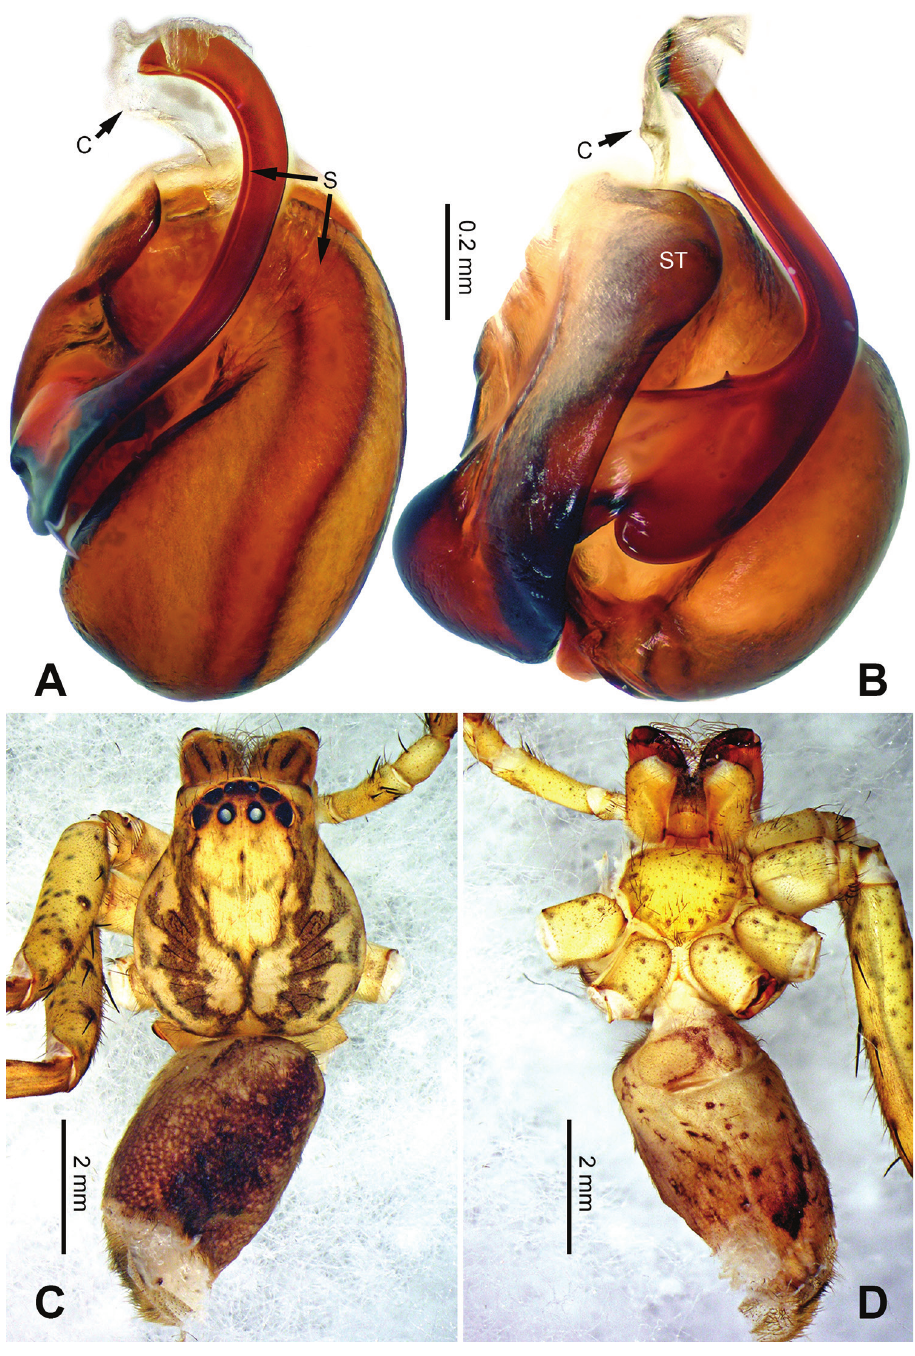
Figure 7. Pseudopoda conaensis Zhao & Li, sp. n., male holotype. A Bulb, ventral view B Bulb, dorsal view C Habitus, dorsal view D Habitus, ventral view. Scale bar equal for A, B